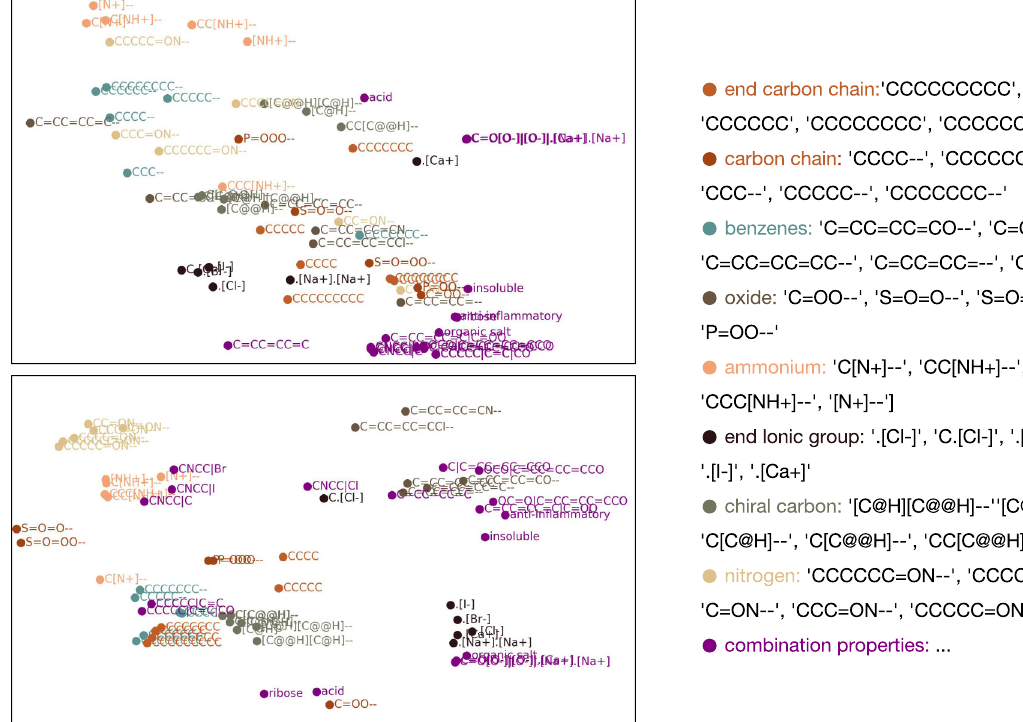
Fig. 4 Visualizing substring pattern embeddings using t-SNE 62 . Parts of substring pattern fi ngerprints are randomly chosen and processed for dimensionality reduction. Similar substring patterns are marked in the same colors. The upper one shows fi ngerprints from pre-trained KV-PLM*, and the lower one is from the model fi netuned on